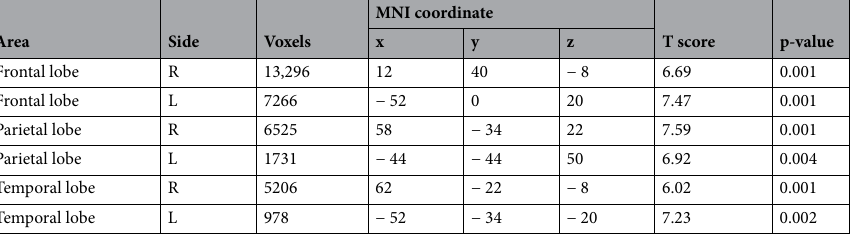
Table 3. The summary of cluster-level statistics of the identified hypoperfused regions in post-COVID-19 patients compared to healthy controls (anatomical regions, cluster sizes, MNI coordinates of peak locations, as well as t-score and p-values).